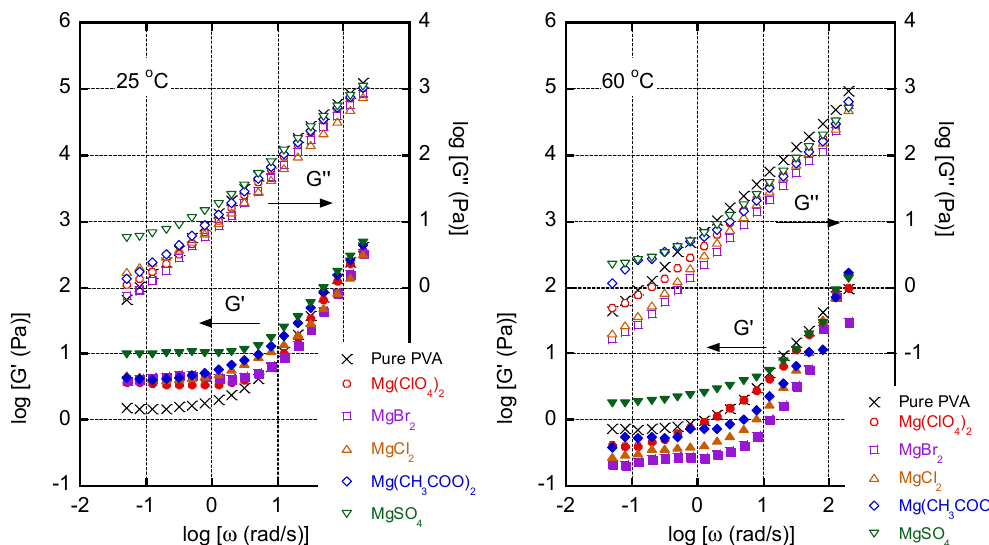
Figure 1. Angular frequency ( ω ) dependence of shear storage modulus G’ and loss modulus G” of aqueous PVA solutions at 25 °C ( left ) and 60 °C ( right ); (x symbols) PVA, (circles) PVA/Mg(ClO 4 ) 2 , (squares) PVA/MgBr 2 , (triangles) PVA/MgCl 2 , (diamonds) PVA/Mg(CH 3 COO) 2 , and (inverted triangles) PVA/MgSO 4 . The molar ratio of magnesium salts to PVA hydroxyl groups was 0.05.